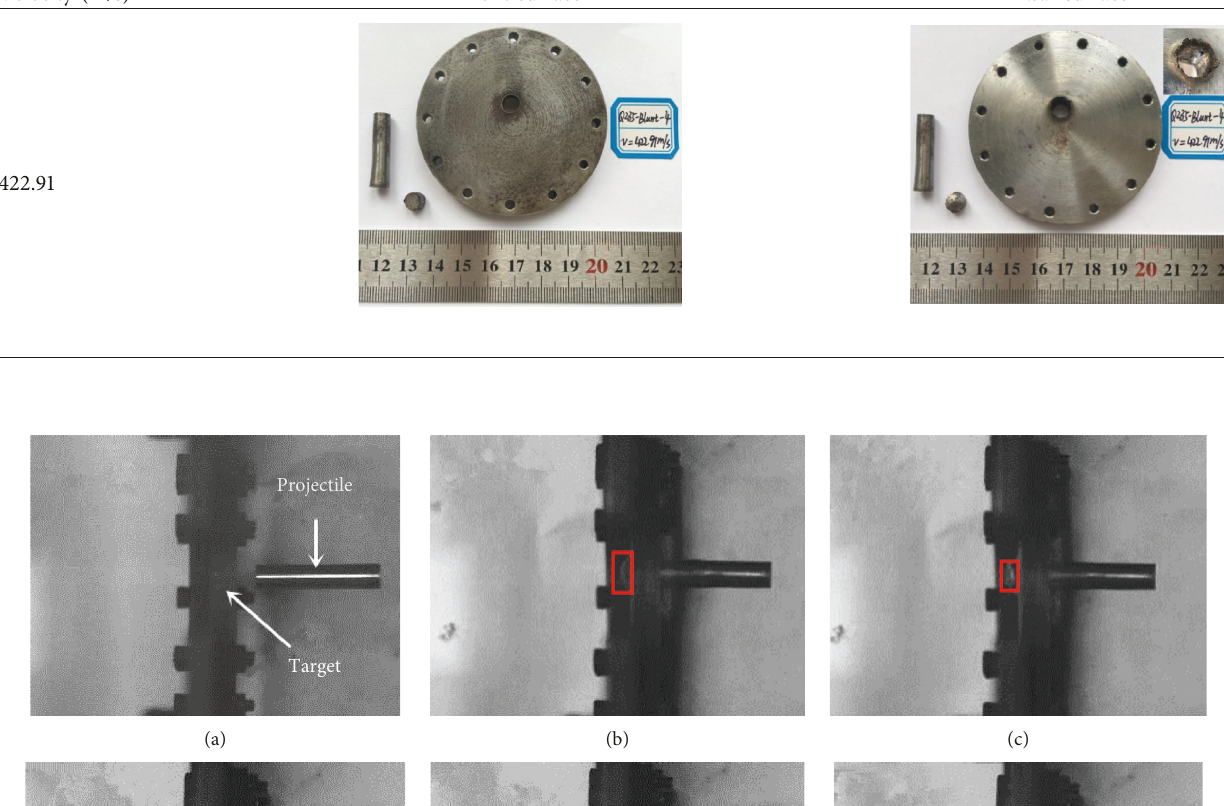
� 272.48m/s. (a) t � 0 μ s. (b) t � 33 μ s. (c) t � 50 μ s. (d) t � 66 μ s. i